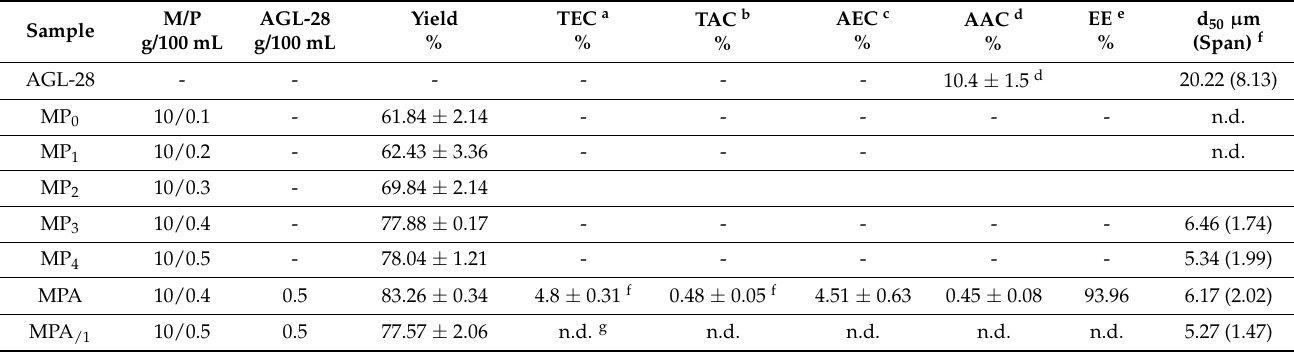
Table 7. Composition and characteristics of raw materials and spray-drying